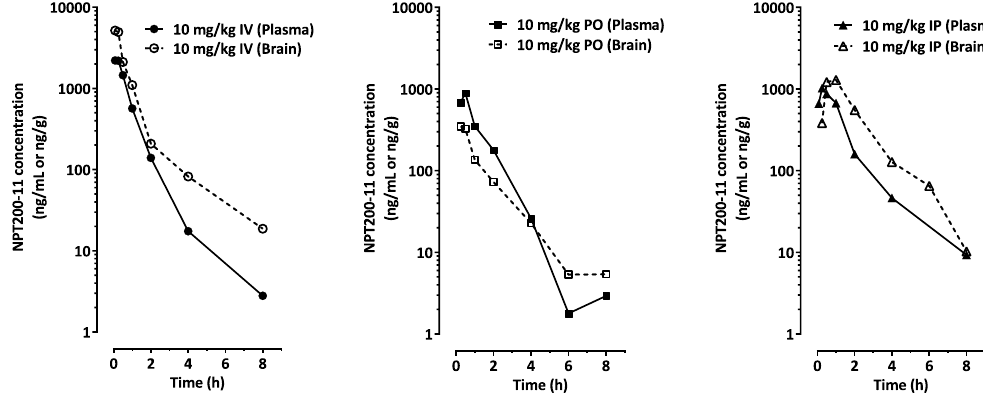
Figure 1. Brain levels of NPT200-11 parallel plasma levels following all routes of administration in C57BL/6 mice. Compound exposure data are presented as group means for specific time points ( from left to right ) for intravenous, oral, and intraperitoneal administration.